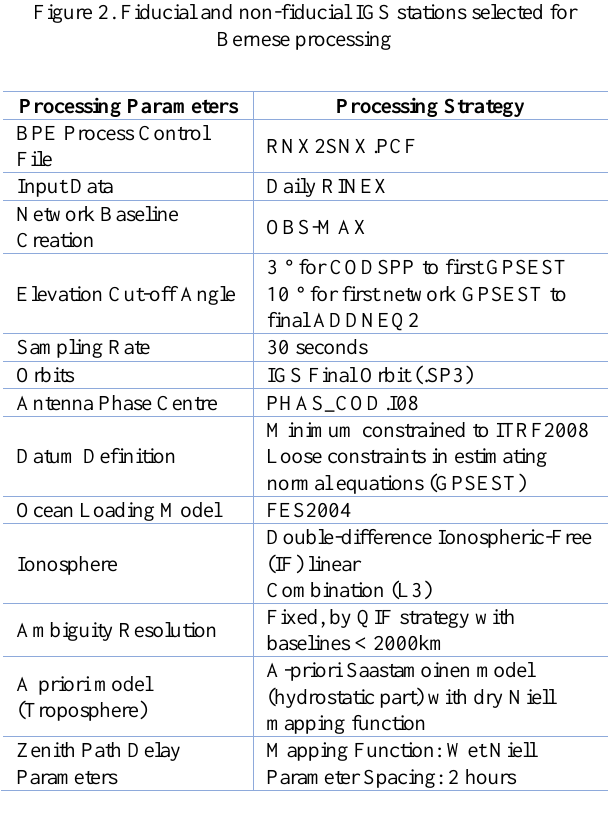
Table 1. Processing strategy and parameters used for Bernese